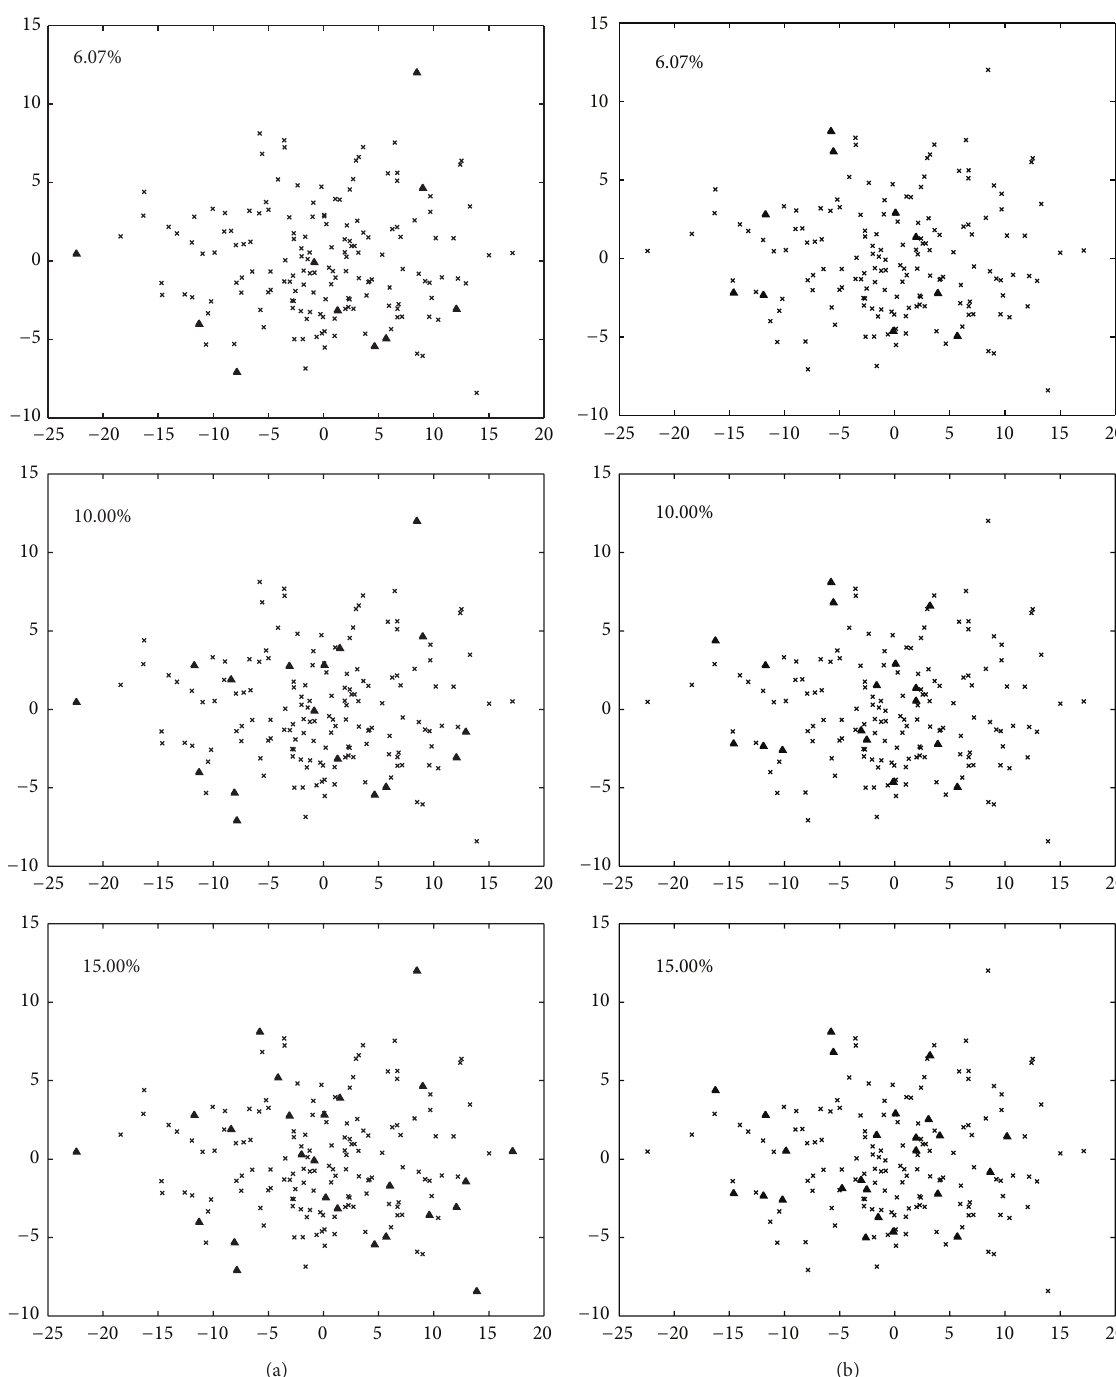
Figure 4: Principal component plots of core accessions and reserve accessions in the sampling percentages of 6.07%, 10%, and 15%. The axes represented the first two principal components. The upward pointing triangles represented the core accessions; the crosses represented the reserved accessions. The left column showed plots for subcore collection constructed by LDSS method based on Seuclid distance combining UPGMA cluster method (treat); the right column showed plots for subcore collection constructed by complete random selection